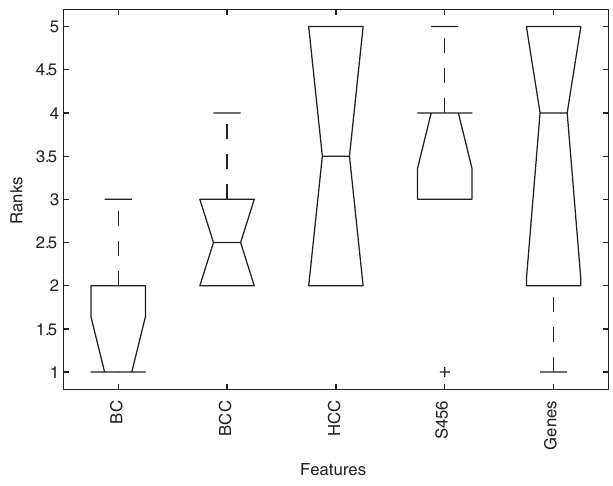
Figure 5. Boxplot showing ranked AUC results. Boxplot showing the median ranks of the performance of each of the five feature types across the six experiments (see Table 1). In each of the six experiments the features were ranked based on the AUC obtained on the independent validation set (1 best, 5 worst).